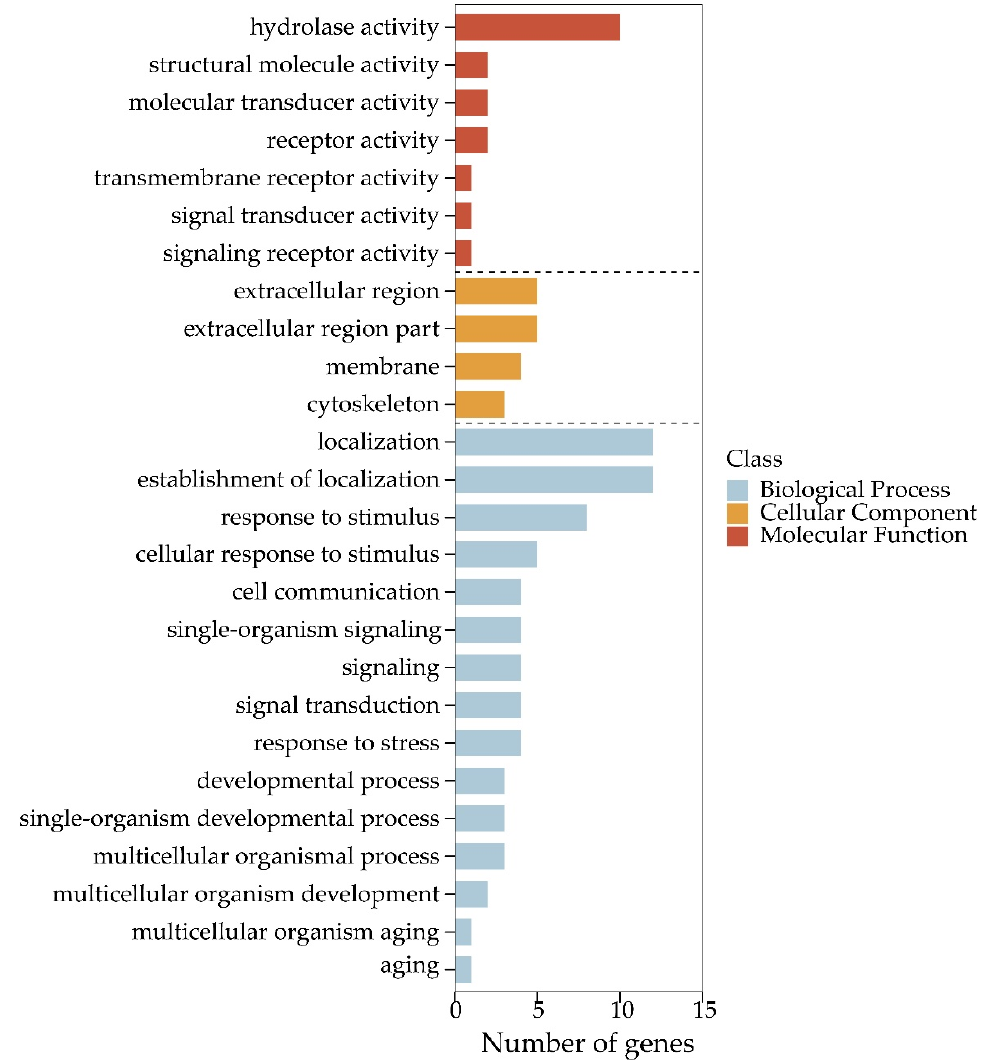
Figure 5. Gene Ontology classifications for 566 functional genes (FGs).